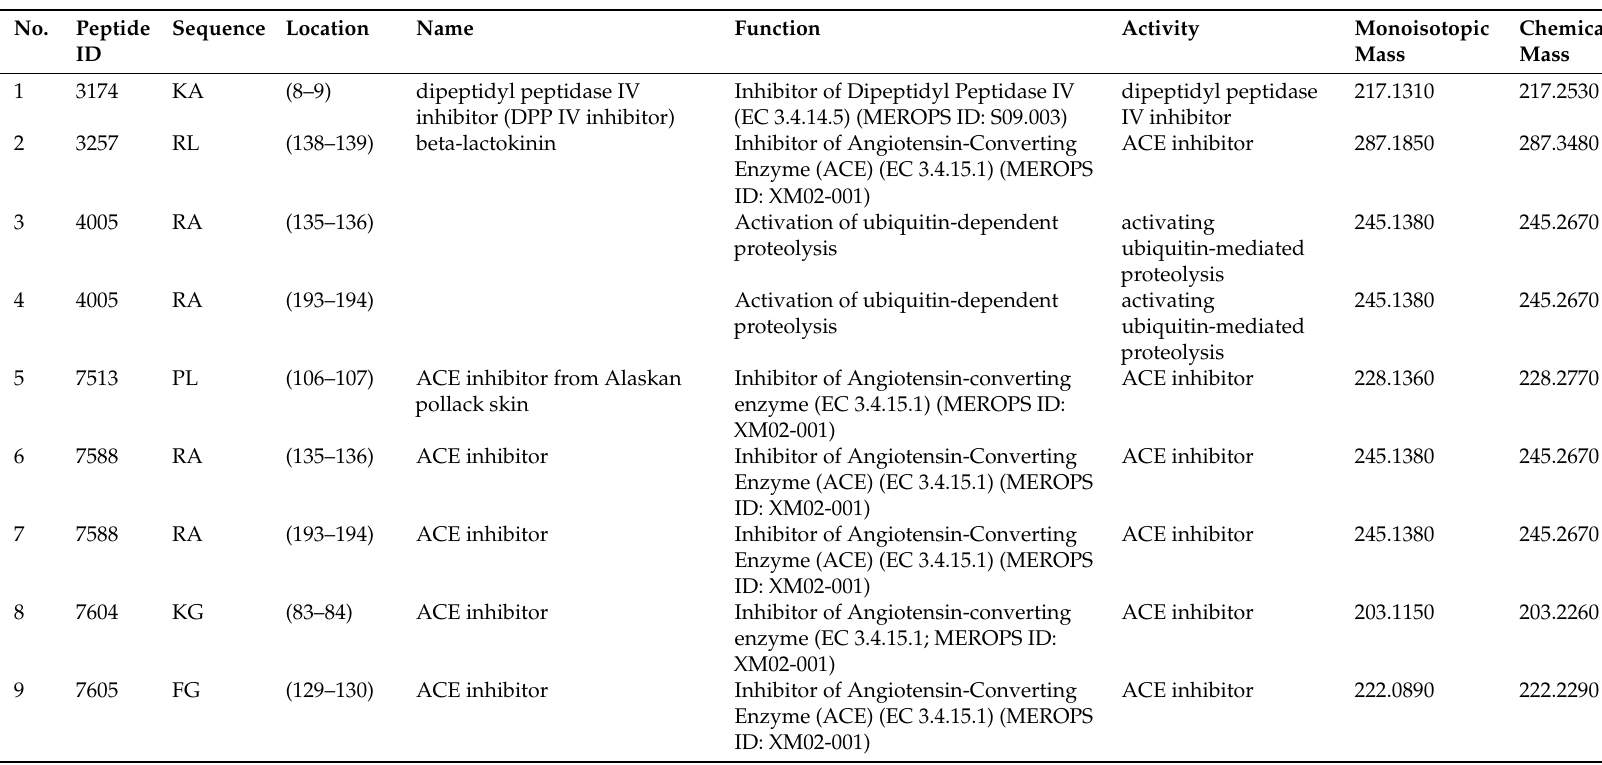
Table A9. Bioactive peptides from RubisCO of Halophila stipulacea . In silico enzymatic cleavage was carried out by using pancreatic